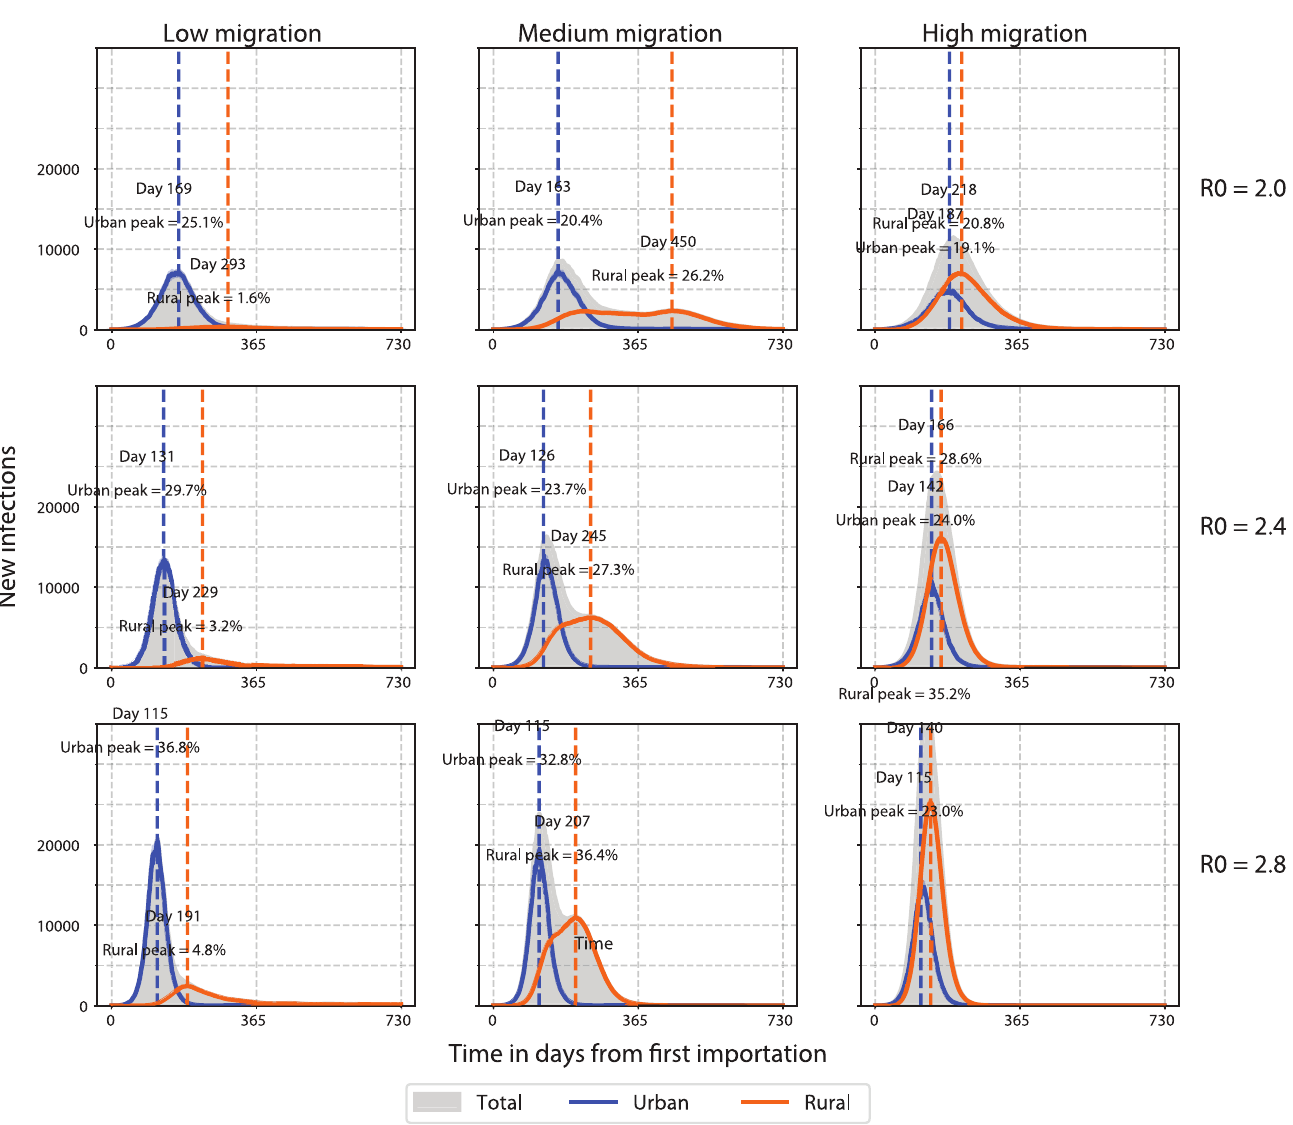
Fig 6. Daily COVID-19 incidence with varying transmission and migration in an archetypal SSA country setting. Urban and rural curves show new cases per day out of a population of 400 000 individuals split 40% urban and 60% rural. Peak percentages represent cumulative incidence as a percentage of the respective sub-population on the date when the highest incidence in each sub-population occurs indicated by the dashed vertical line. Time in days since first imported case. Low, medium, and high migration = 2000, 20 000, and 200 000 dtpmi,